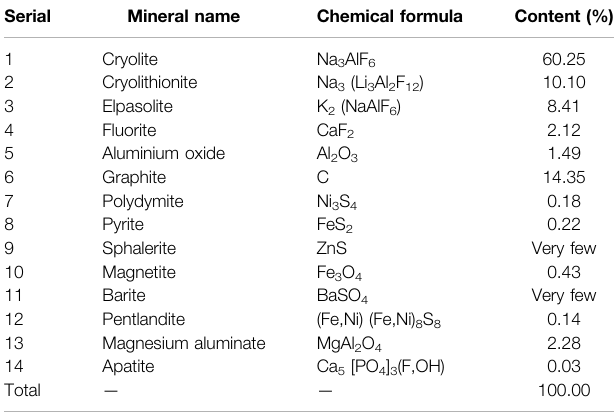
TABLE 2 | Mineral composition and content